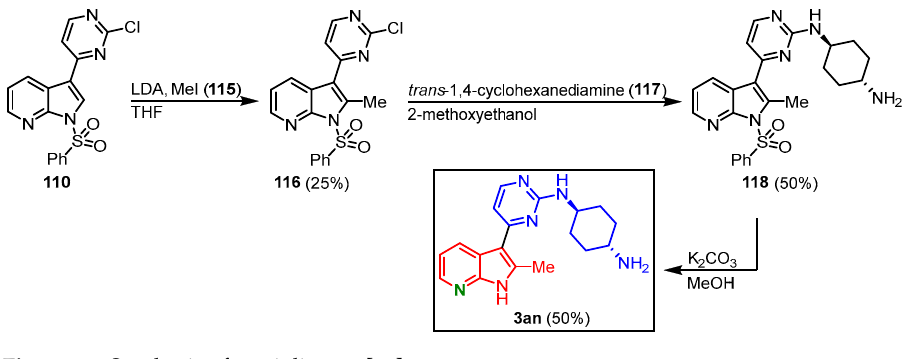
Figure 32. MBSC sequence for the synthesis of meriolins 3a and 3ao - bi by Müller [18,63].